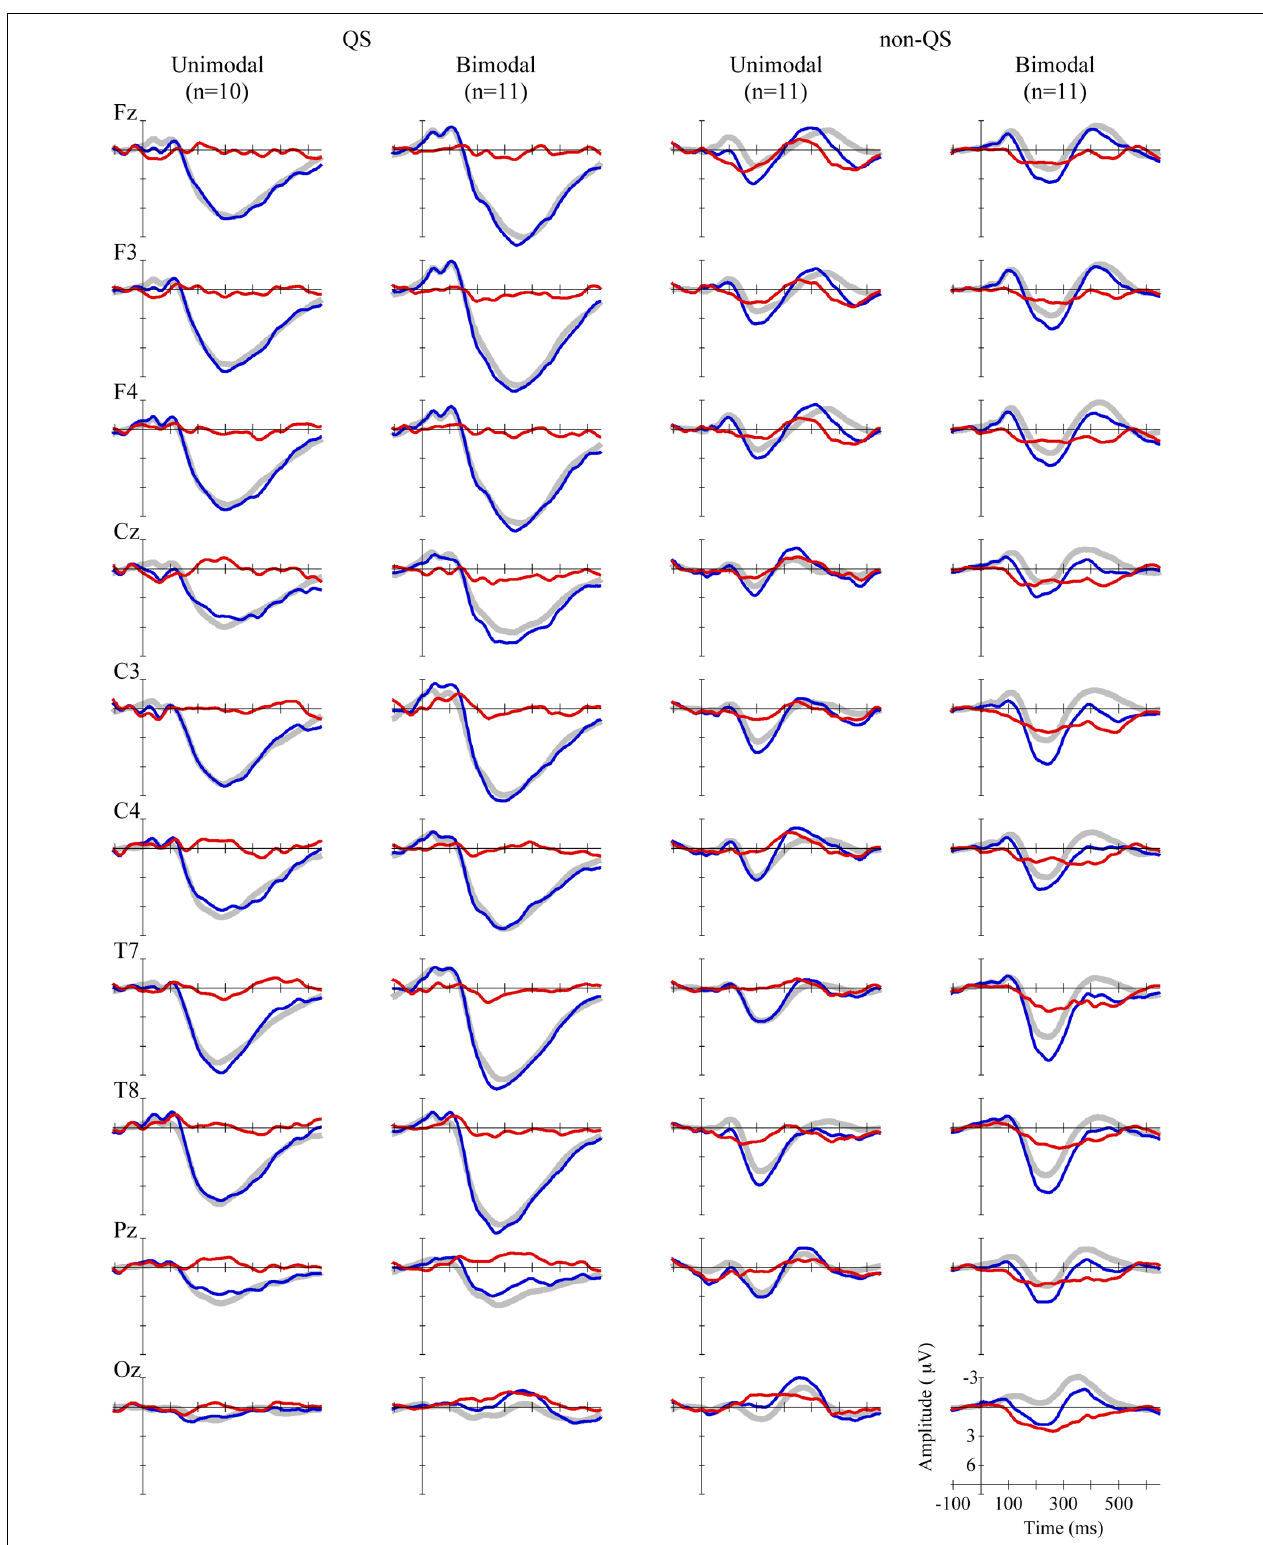
FIGURE 2 | Grand average standard (gray, thick curves), deviant (blue, thin curves), and MMR (red, thin curves) waveforms, at 10 electrodes (see rows), for unimodally and bimodally trained infants in QS (left two columns), and non-QS (right two columns).